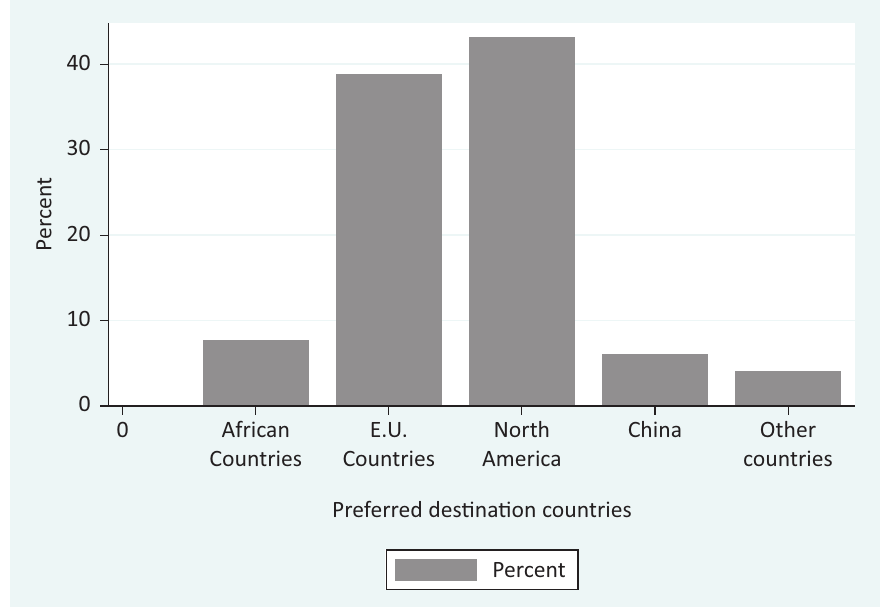
Figure 1. Destinations of choice for students from